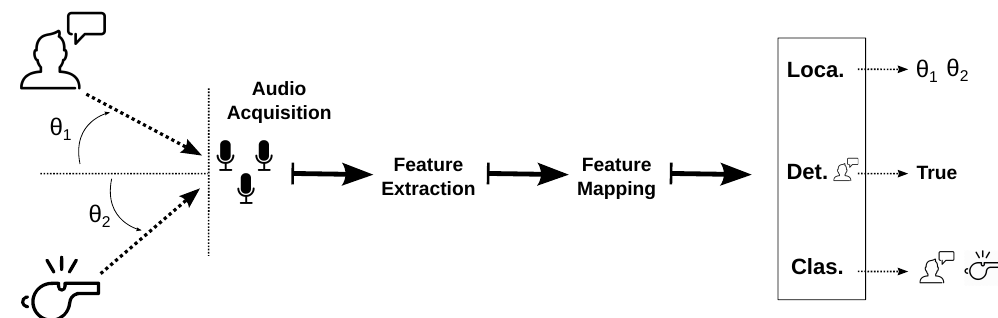
Figure 3. Modular framework paradigm for computational auditory perception: First, audio signals from different sources are acquired with a microphone system; then, audio signals are processed to extract features and and are mapped to a solution space where the transform features can be processed and interpreted to resolve one or more of the objectives in the auditory perception: detection, localization, and/or